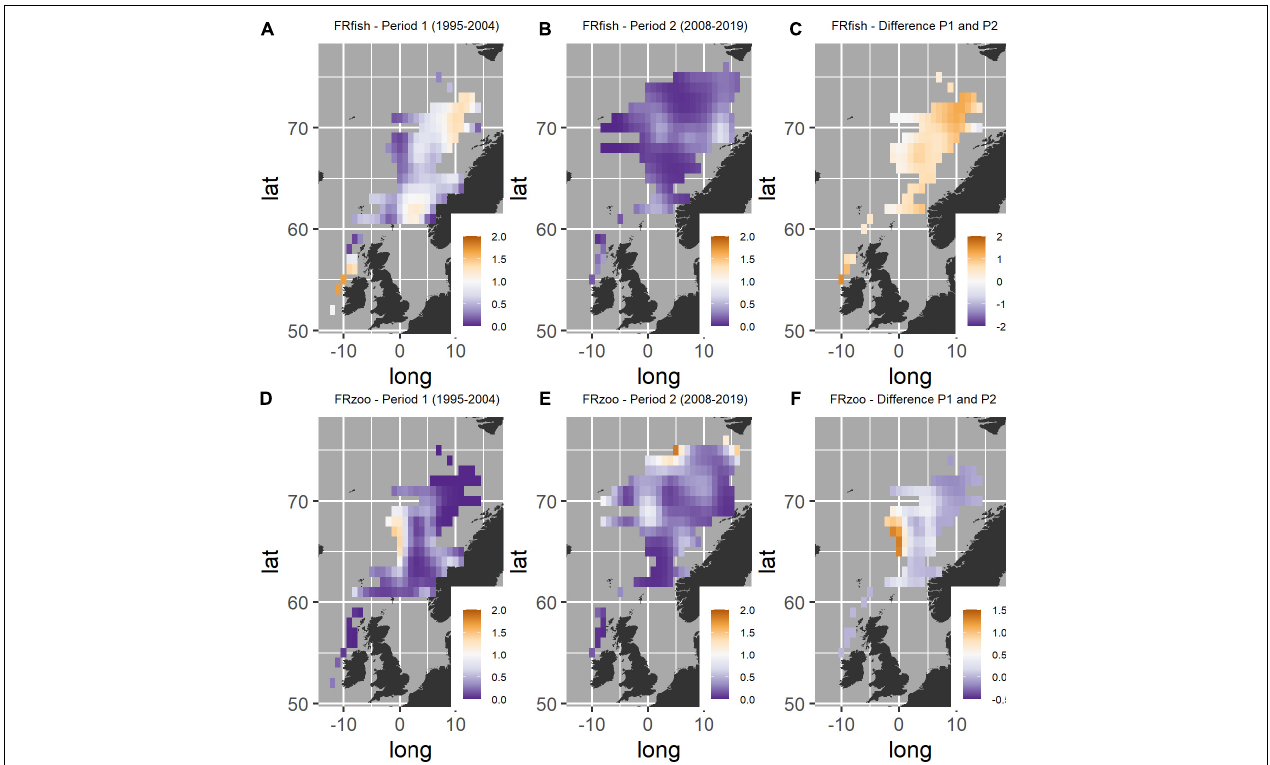
FIGURE 4 | Geographic variation in feeding ratio (FR) estimated by using a hurdle model in areas of the Northeast Atlantic Ocean. (A) FR fish in period 1 (1995–2004), (B) FR fish in period 2 (2008–2019), (C) difference in FR fish between period 1 and 2 where positive values indicate that the FR fish was highest in period 1, (D) FR zoo in period 1, (E) FR zoo in period 2, and (F) difference in FR zoo between period 1 and 2 where positive values indicate higher values in period 1. The figure was produced with the use of the following R-packages: ggplot2 (Wickham, 2016) and gridExtra (Auguié, 2017).